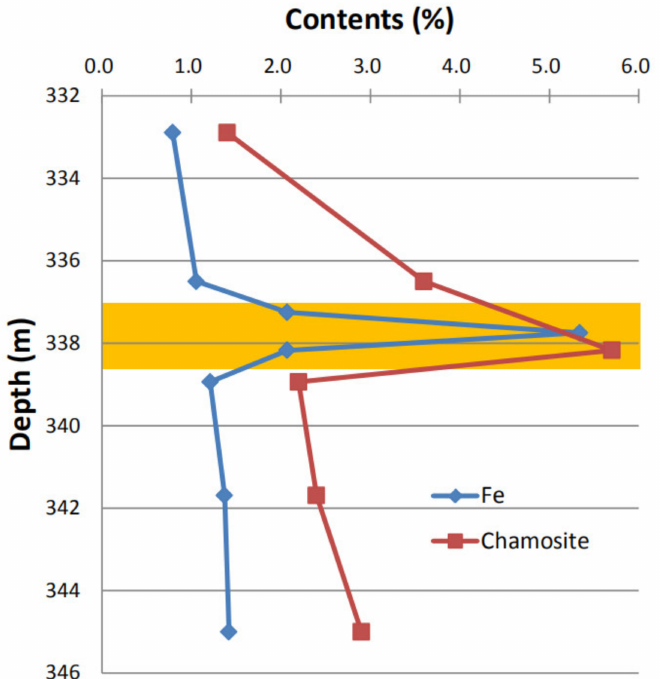
Figure 6. Vertical variations of contents of chamosite and Fe in studied samples. The orange bar indicates the location of Fe-plugging as revealed by geological description of core